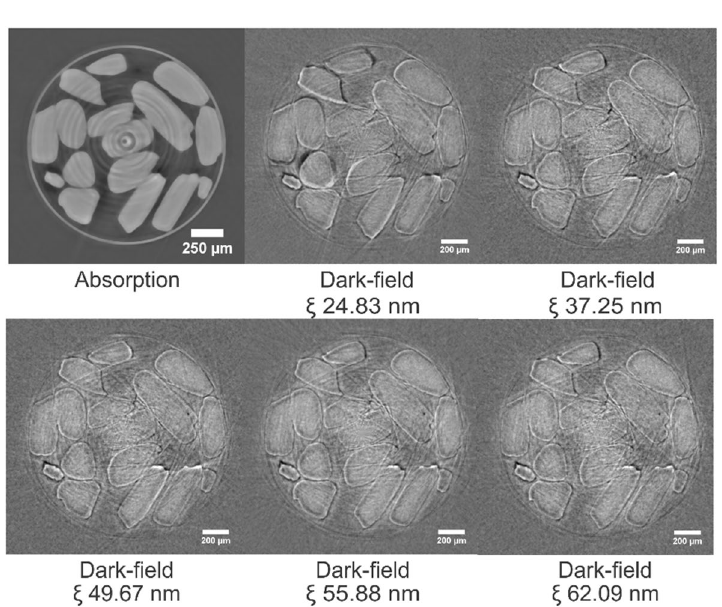
Figure 4. The dark-field signal changes as a function of the correlation length ( ξ ) . The sample consists of mixed particles with either a mean nomimal pore size of 50 or 150 nm. Tomograms were obtained at eighteen correlation lengths between 24.83 and 434.60 nm. Dark-field cross-sections of the five smallest correlation lengths are